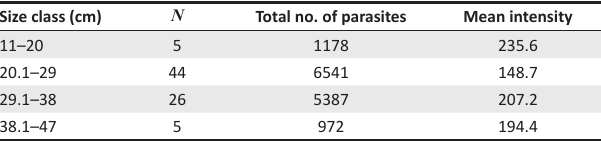
TABLE 4: Total number of parasites and mean intensity in each size class of Hydrocynus vittatus. Size class (cm) N Total no. of